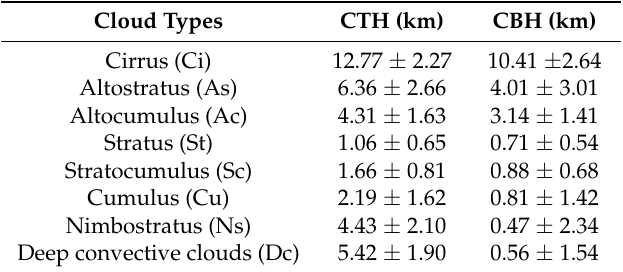
Table 1. Means and SDs of cloud top height (CTH) and cloud base height (CBH) for the eight cloud types selected in this study